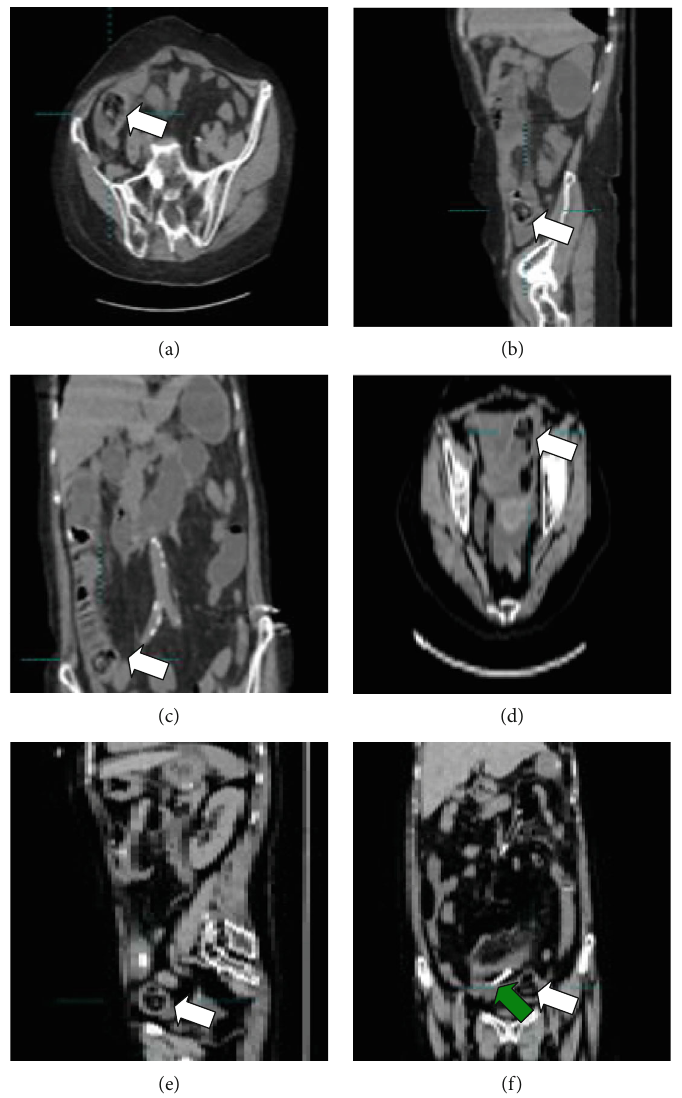
Figure 1: (a – c) Abdominal CT shows an intestinal mass considered to be a phytobezoar in the ileum (white arrow), proximal intestinal dilation, and intestinal e ff usion. (d – f) The green arrow indicates the transnasal ileus tube placed in the intestinal cavity on the 3rd day; the position of the phytobezoar (white arrow) is lower than previous position; small bowel obstruction is reduced.